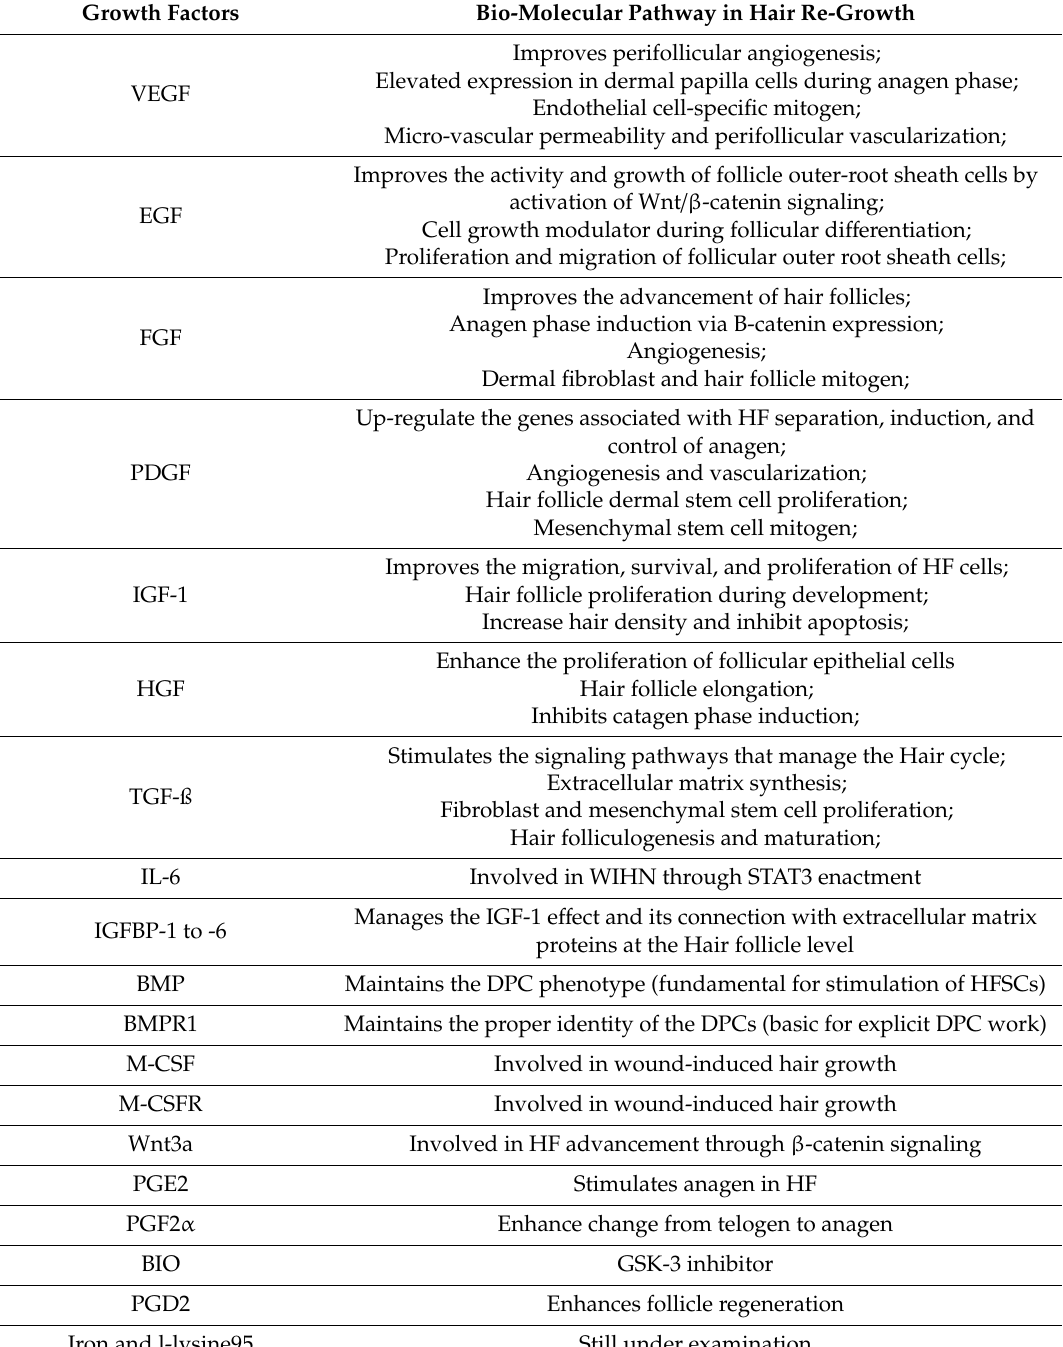
Table 3. List of GFs identified in PRP and their suggested bio-molecular pathway in the treatment of